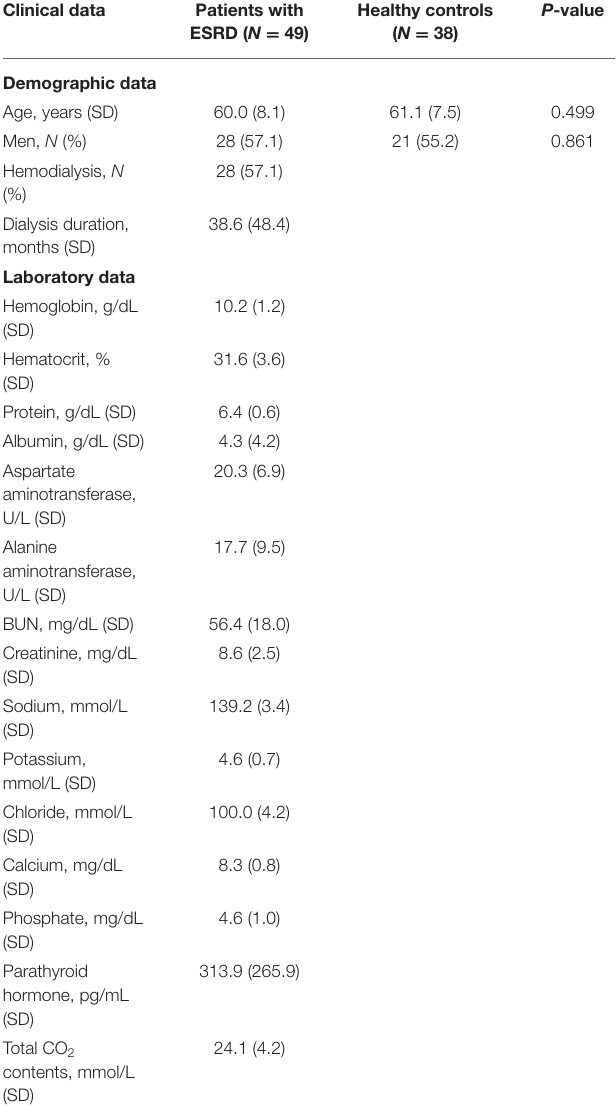
TABLE 1 | Clinical characteristics of the patients with end-stage renal disease (ESRD). Clinical